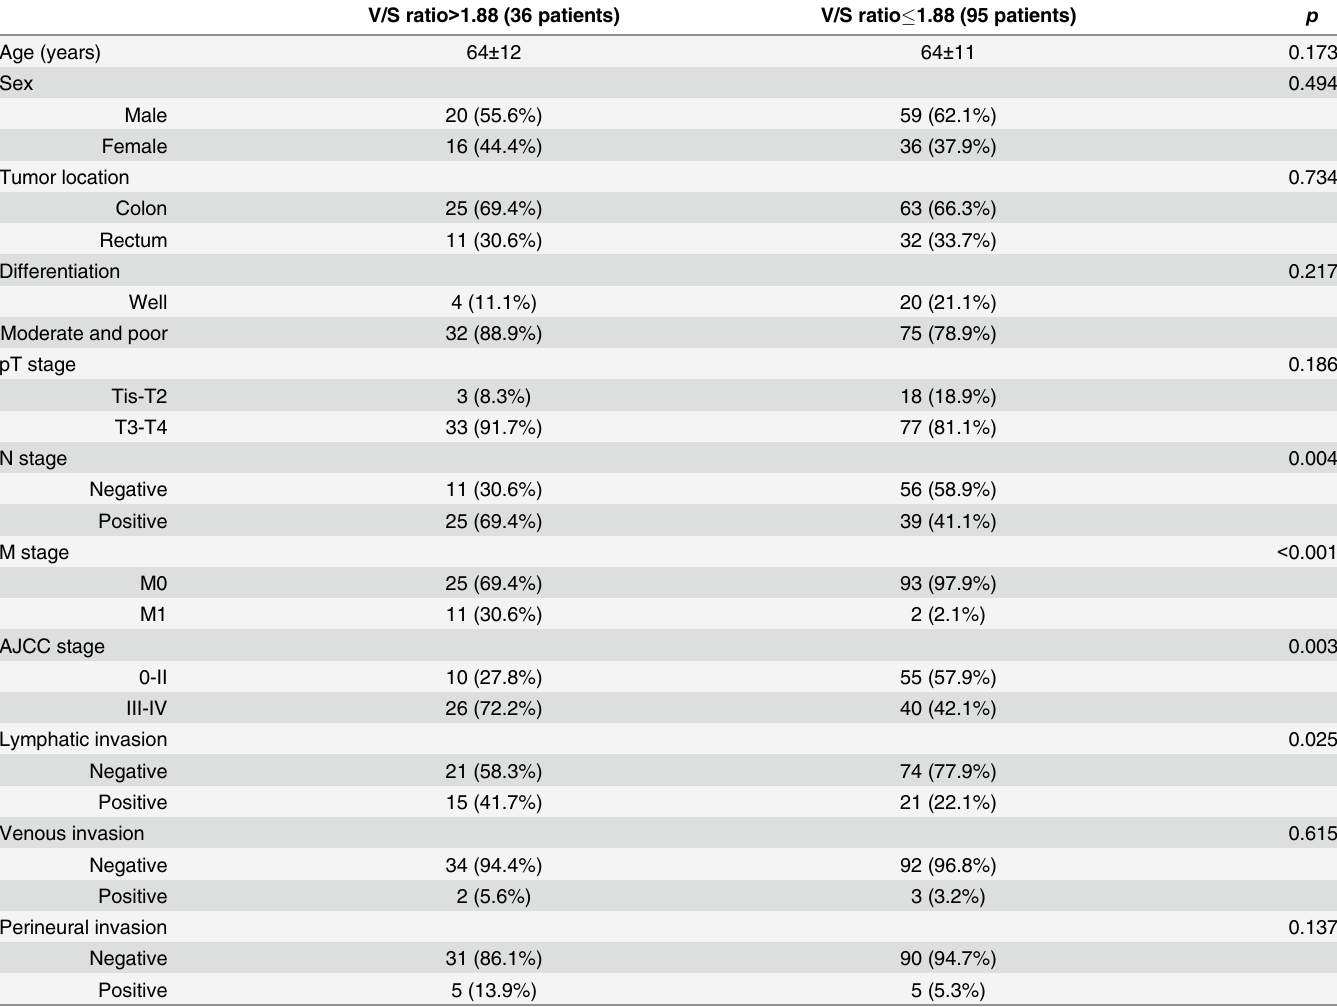
Table 2. Patient characteristics with functional visceral fat activity. V/S ratio > 1.88 (36 patients) V/S ratio (cid:2) 1.88 (95